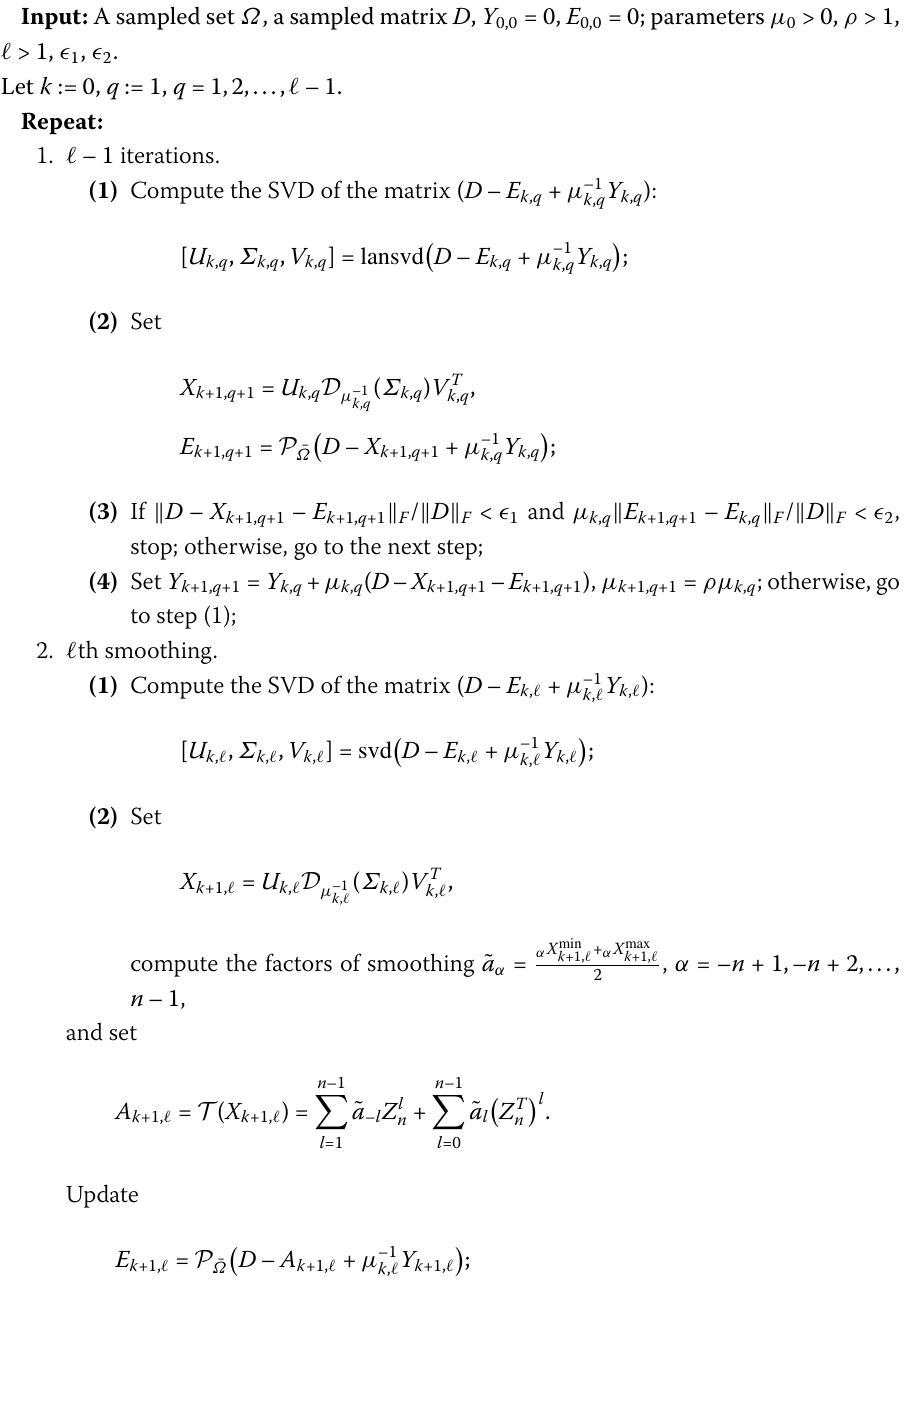
Algorithm 3.3 (SSALM